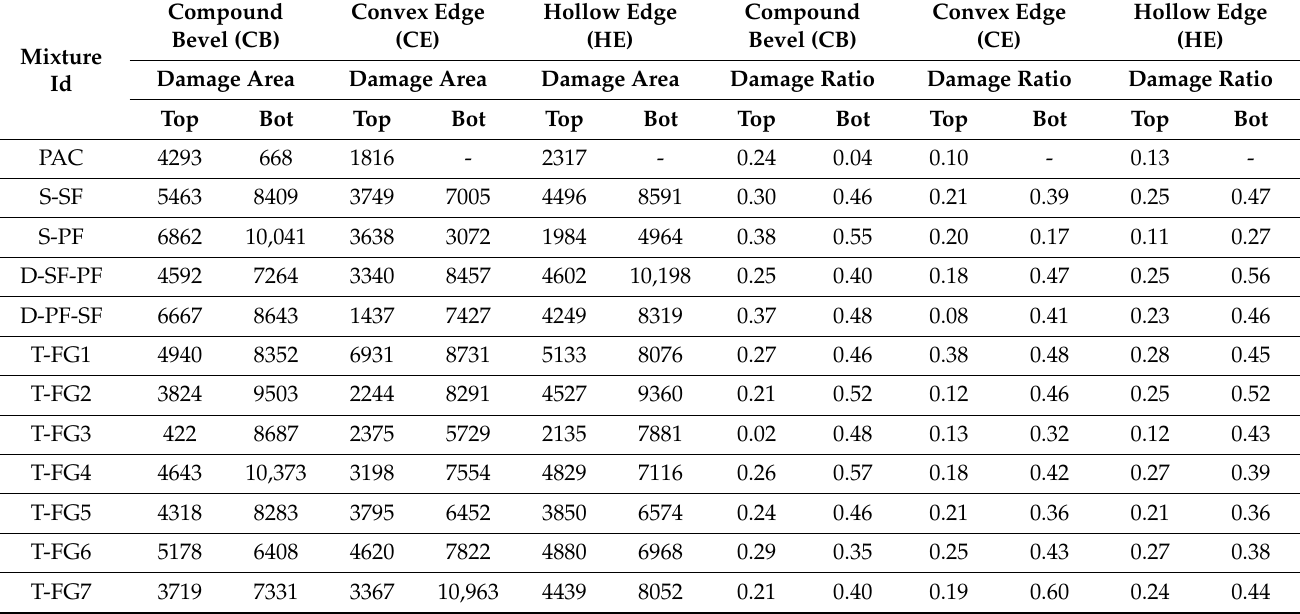
Table 2. Damage area and damage ratio of